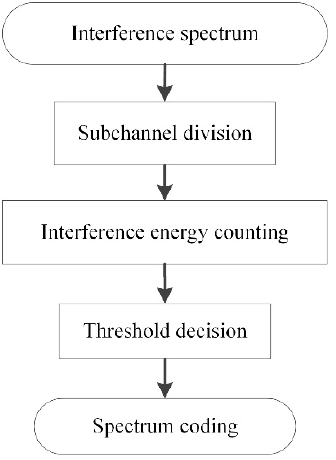
Figure 3. Block diagram of interference spectrum coding.